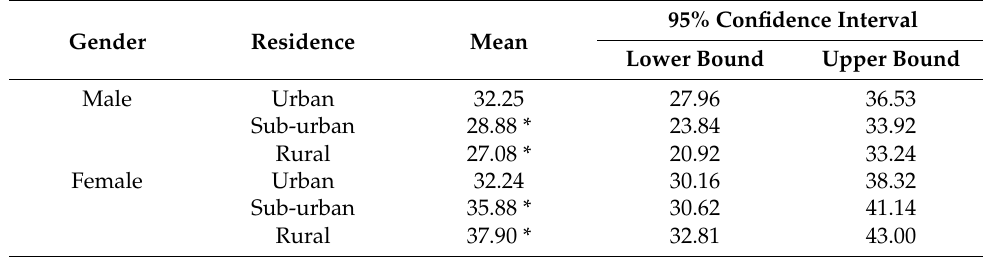
Table 6. The adjusted mean PIDA scores for interaction of gender and